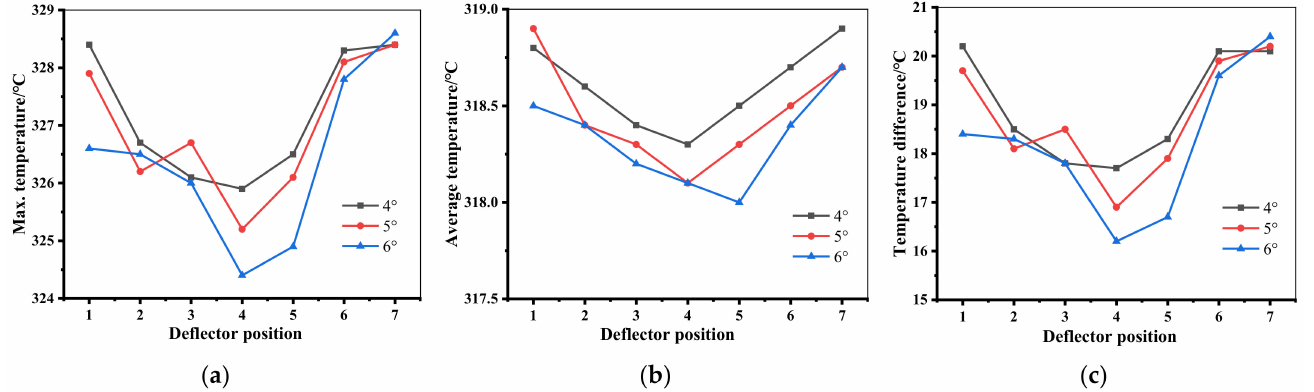
Figure 14. Schematic diagram of deflector plate: ( a ) three-dimensional schematic diagram of the deflector; and ( b ) two-dimensional schematic diagram of the deflector.